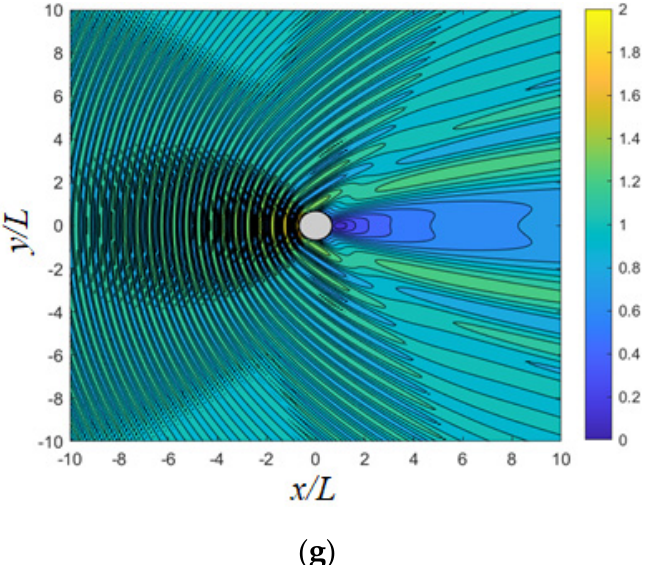
Figure 10. Wave fields for triangular, square, hexagonal, and circular platforms ( T = 10 s): ( a ) triangular platform (Case 1); ( b ) triangular platform (Case 2); ( c ) square platform (Case 1); ( d ) square platform (Case 2); ( e ) hexagonal platform (Case 1); ( f ) hexagonal platform (Case 2); and ( g ) circular platform.